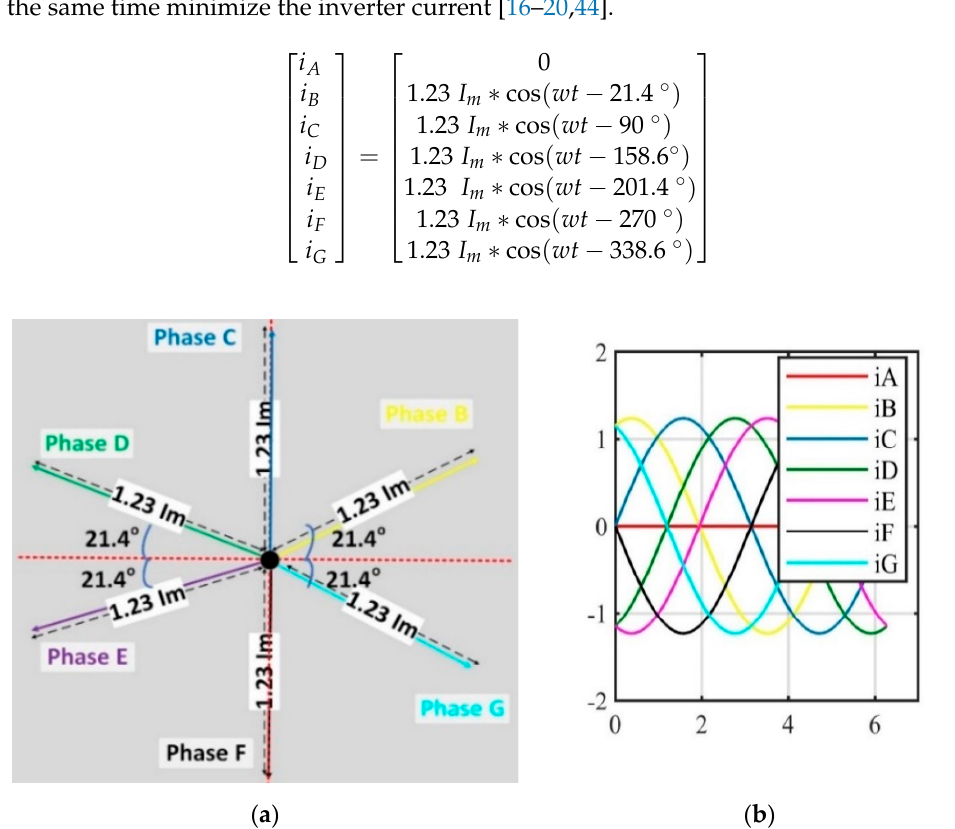
Figure 7. Current distribution of seven-phase motor under minimizing inverter current optimization. ( a ) Phasor; ( b ) sinusoidal.